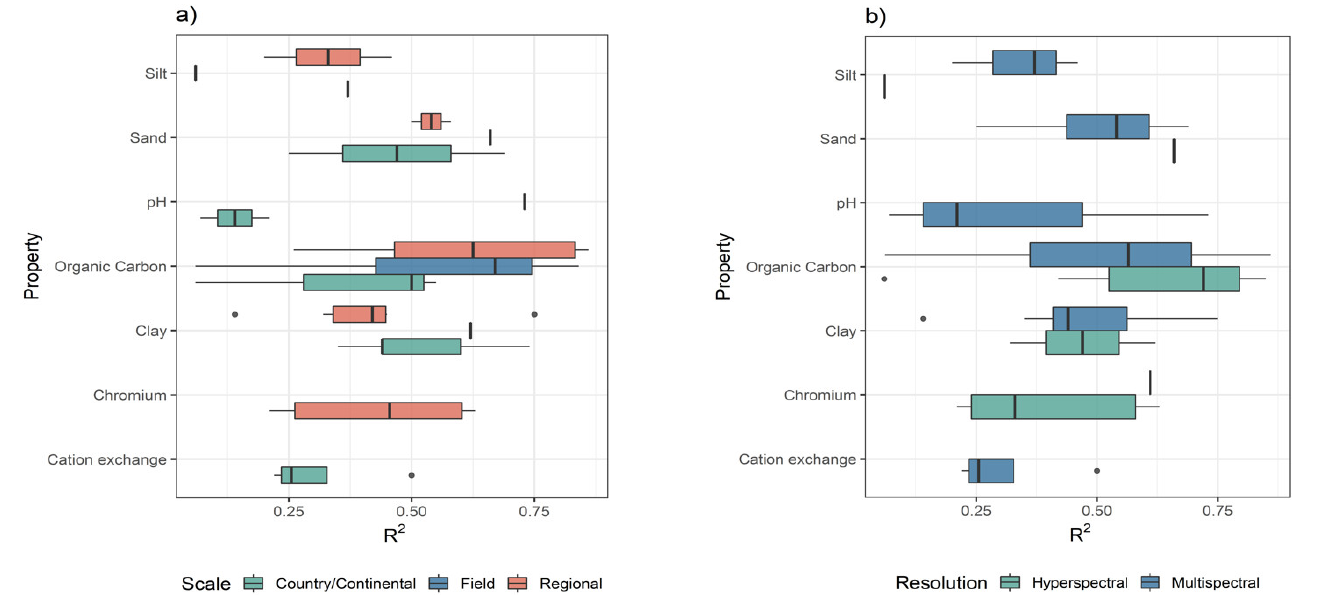
Figure 4. Boxplot of reported R 2 grouped by ( a ) scale and ( b ) resolution in the various pilot cases. The median is shown with a bold black line.